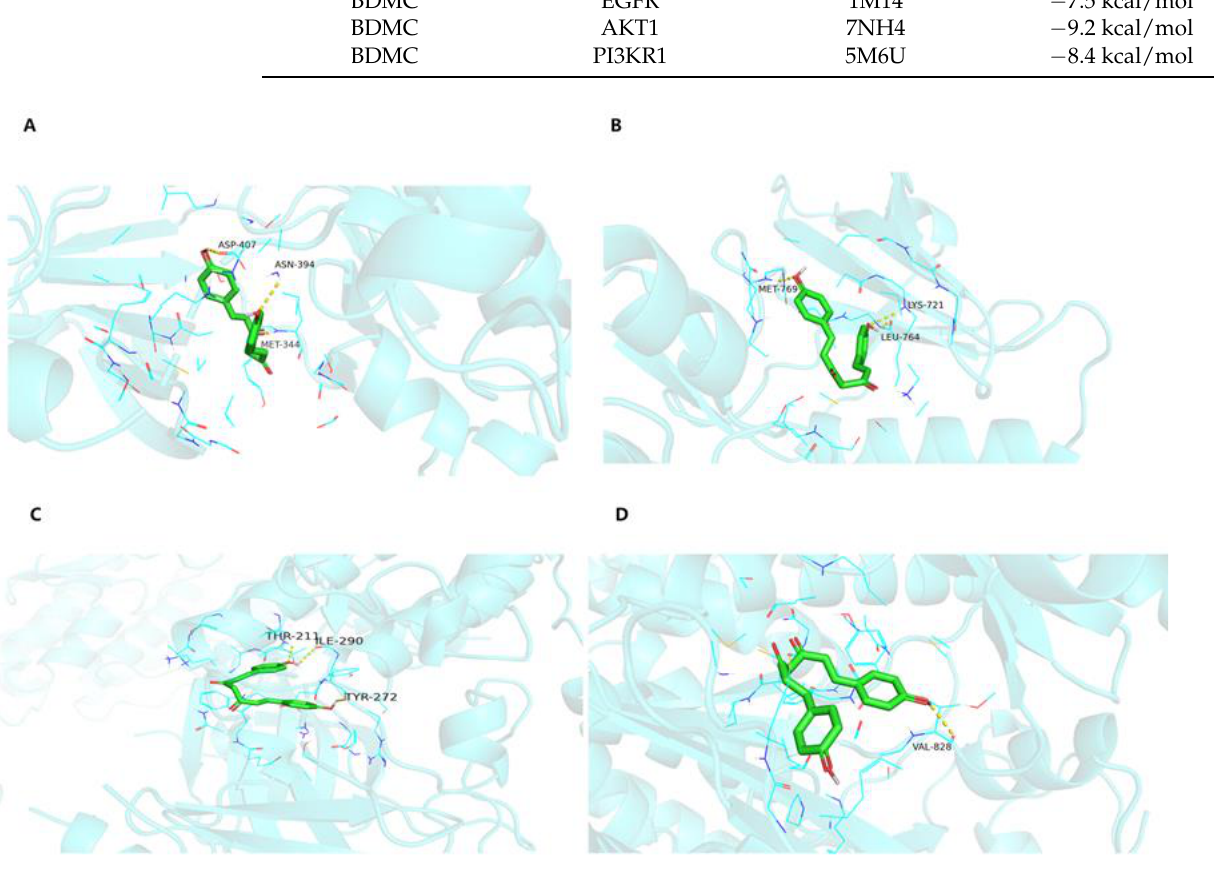
Figure 5. Molecular docking models of BDMC binding to major hub targets. ( A ) SRC with BDMC. ( B ) EGFR with BDMC. ( C ) AKT1 with BDMC. ( D ) PI3KR1 with BDMC. The yellow dashed lines represent hydrogen, whereas the red lines represent π - π interactions.